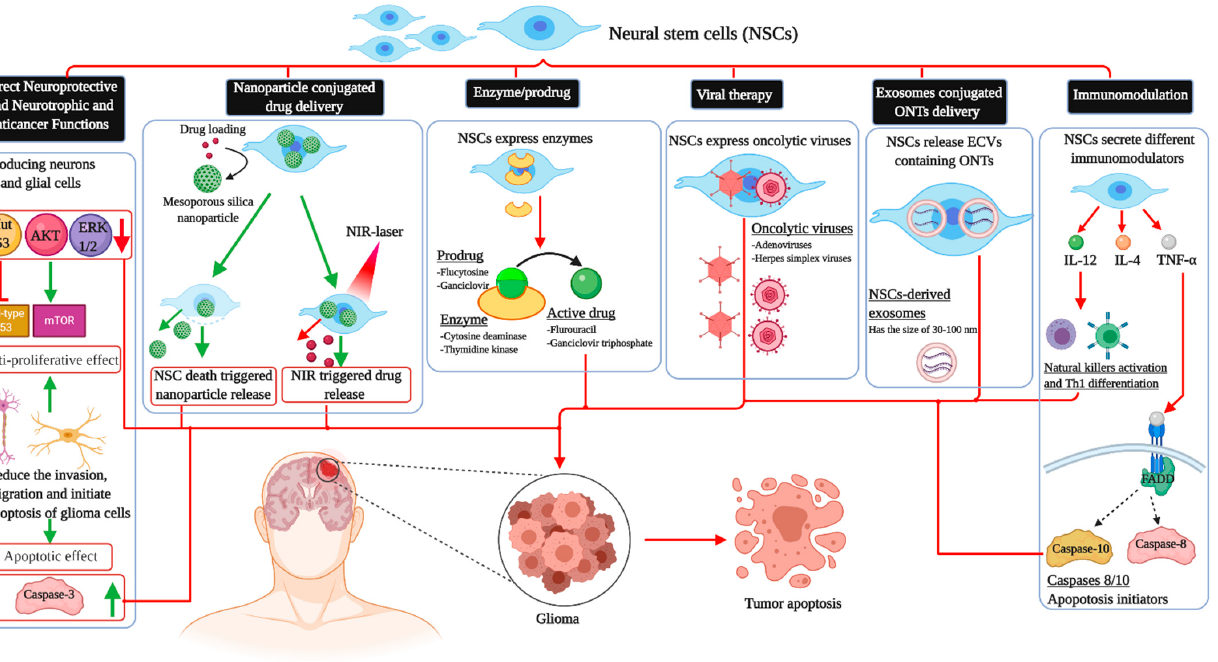
Figure 1. The different applications of neural stem cells in killing glioblastoma cells. NSCs: Neural stem cell; AKT: Protein kinase B; ERK1/2: Extracellular-regulated kinase; TNF- α : Tumor necrosis factor alpha; IL-4: Interkelukin-4; IL-12: Interkelukin-12; FADD: FAD-associated protein with death domain; ONTs: Oligonucleotide therapeutics; Th1: T helper 1; mTOR: Mammalian target of rapamycin; NIR: Near-infrared; ECVs: Extracellular vesicles.